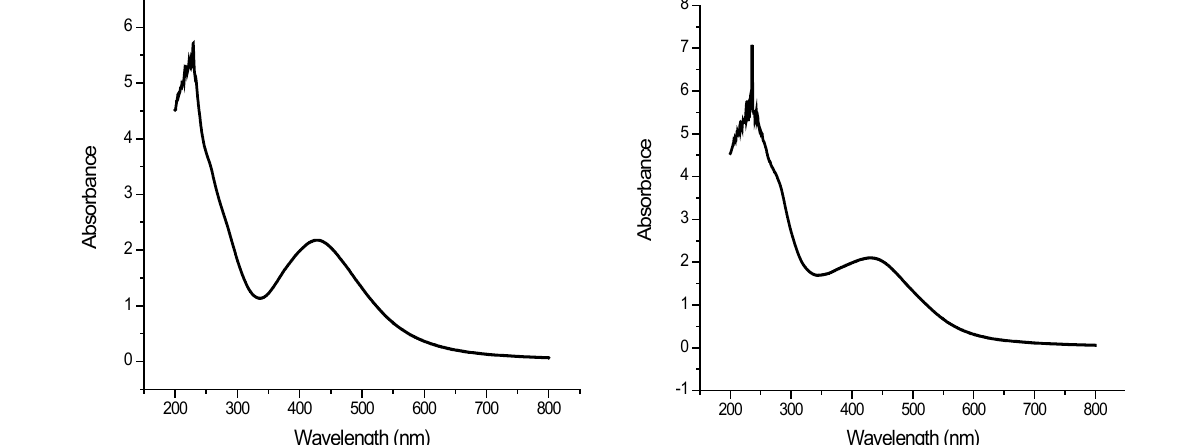
Fig. 3 (b): Time dependent Biosynthesis of GS-RAgNPs Fig. 3 (a): Time dependent Biosynthesis of GS-SAgNPs